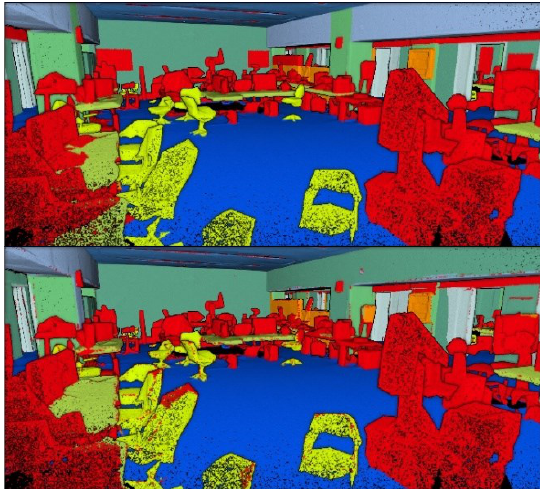
Figure 8 Ground Truth (Top) vs Classified result